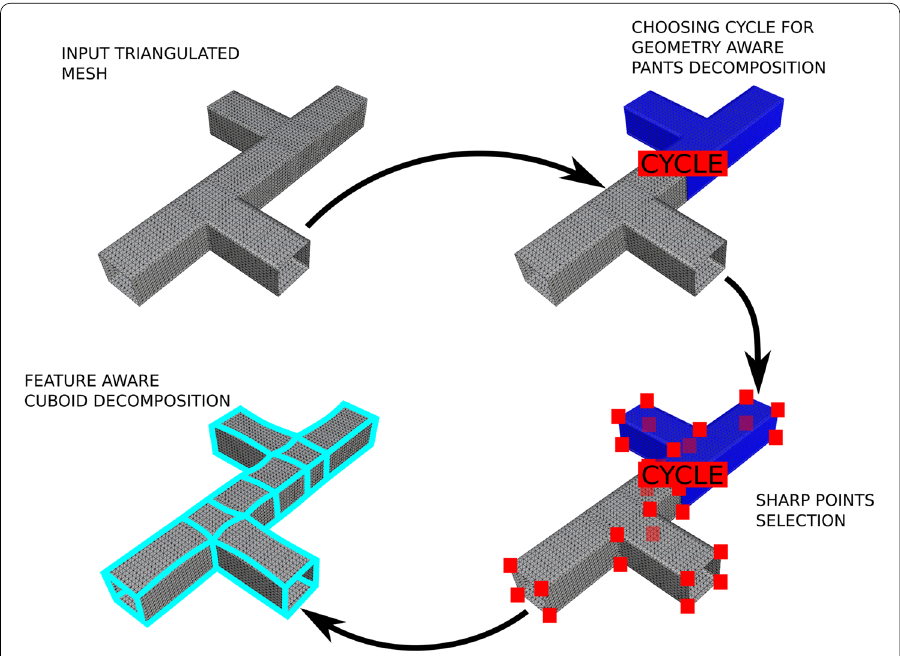
Fig. 11 Geometry-feature-aware pants-to-cuboids decomposition algorithm: mechanical pipeline details